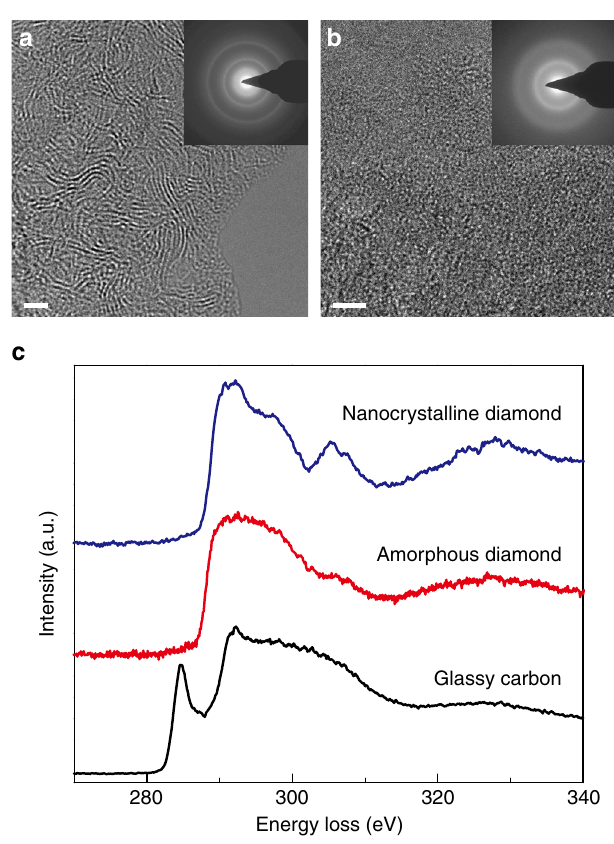
Fig. 2 TEM studies of the recovered sample. a HRTEM and selected area electron diffraction ( SAED ) images of glassy carbon b HRTEM and SAED images of the recovered amorphous diamond sample revealing the amorphous structure. The scale bars in a and b represent 2 nm. c Carbon K-edge EELS of glassy carbon ( black ), the recovered amorphous diamond sample ( red ) and nanocrystallline diamond ( blue ). The fi ne post-edge structures in the EELS of nanocrystalline diamond, e.g. the large dip at ∼ 302 eV which re fl ects the second absolute band gap, are characteristics of crystalline diamond. Their absence in the EELS of amorphous diamond is further evidence of the disordered atomic arrangement in amorphous diamond. We fi nd a similar phenomenon when comparing the EELS patterns of crystalline and amorphous Si